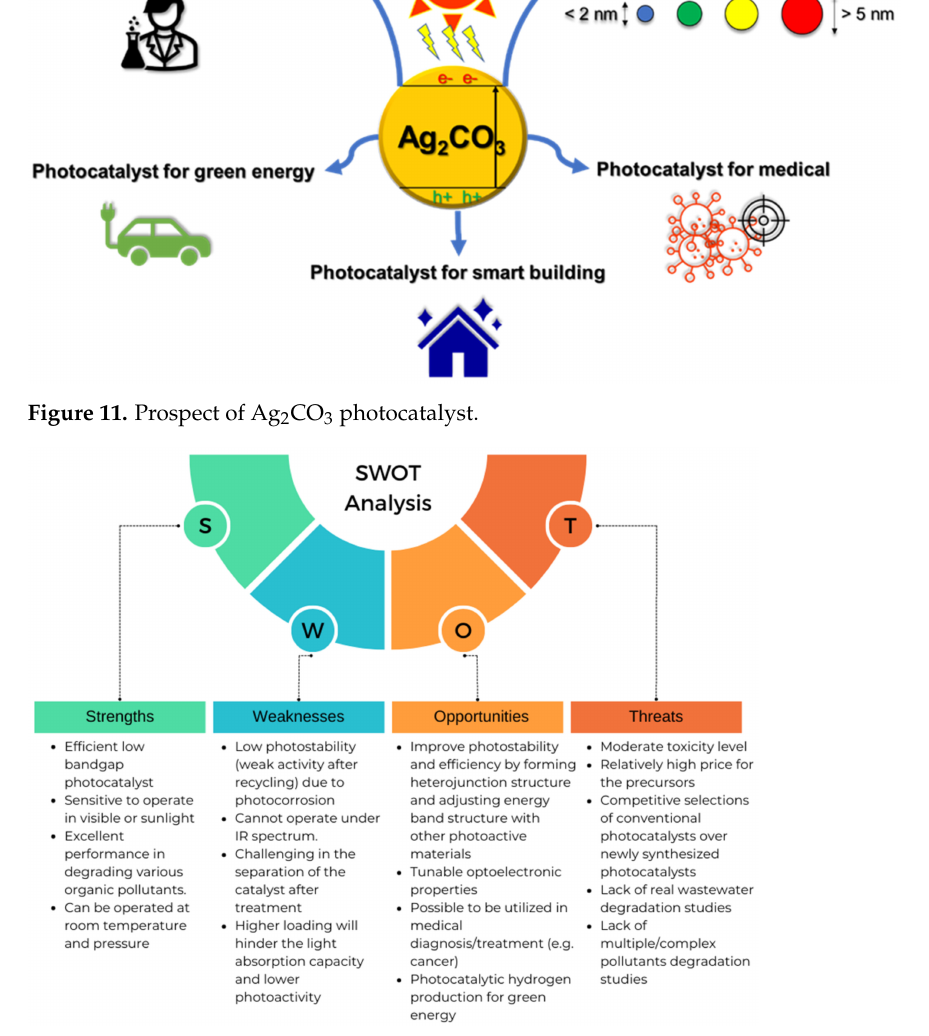
Figure 12. Strengths, weaknesses, opportunities, and threats (SWOT) analysis for Ag 2 CO 3 -based photocatalytic